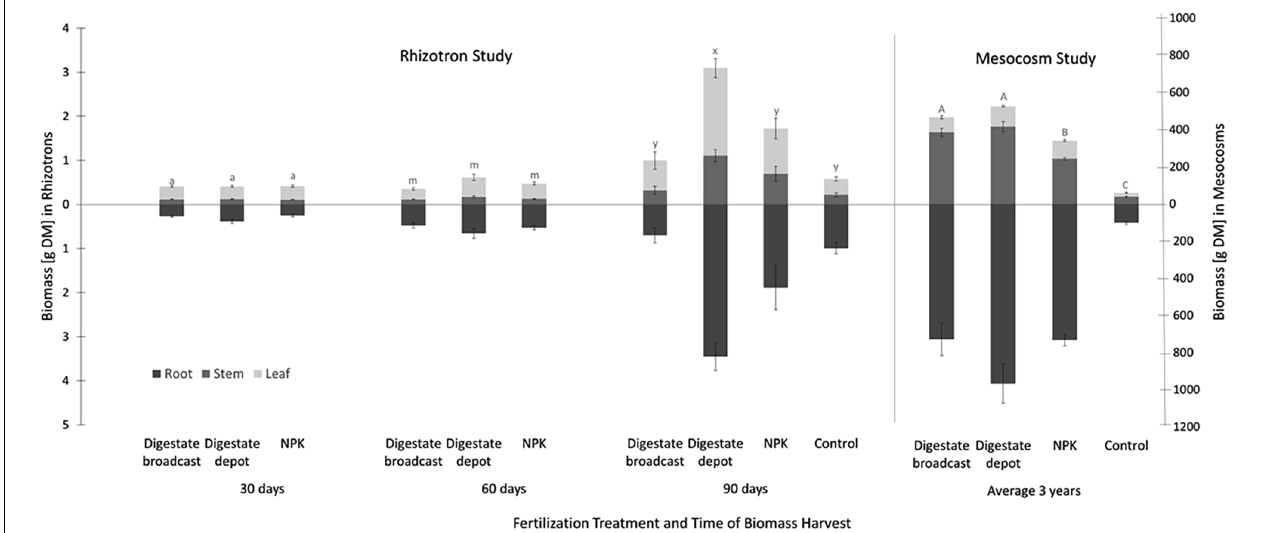
FIGURE 3 | Plant biomass yield of S. hermaphrodita in rhizotrons and mesocosms. All fertilization treatments were adjusted to a digestate application of 40 t ha − 1 . Digestate broadcast: homogeneously incorporated in the top 20 cm; Digestate depot: localized digestate application; NPK: homogeneously incorporated in the top 20 cm; Control: no fertilization. Rhizotrons: n = 8 replicates for each treatment and time of harvest; Mesocosms: n = 7 replicates for each treatment harvested in 2014, 2015, and 2016. Root biomass was only measured in 2016. Values labeled with the same letter are not significantly different at p < 0.05; error bars indicate the standard error.